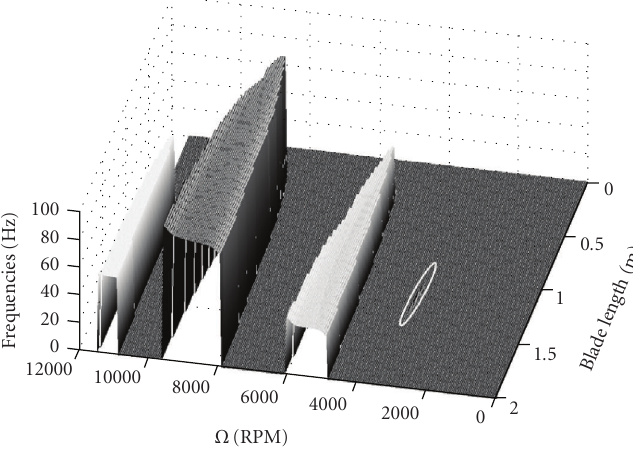
Figure 13: Unstable frequencies of a two-rigid-bladed rotor as a function of its blade length and its rotational speed.